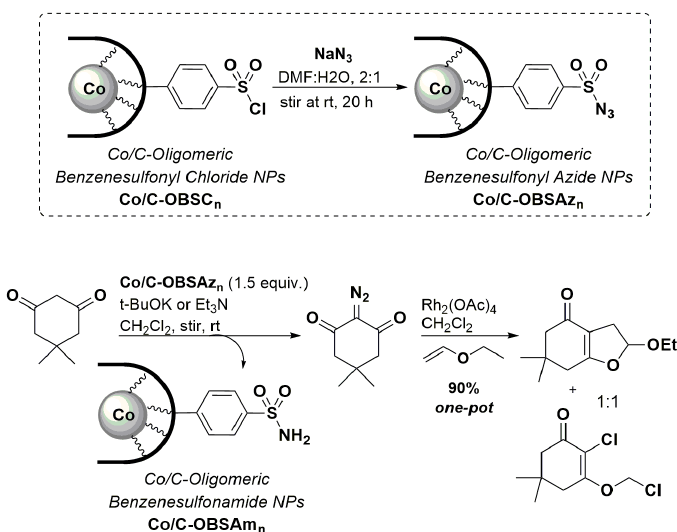
Figure 27 - Magnetic benzenesulfonyl azide as transfer agent in diazo transfer reactions.